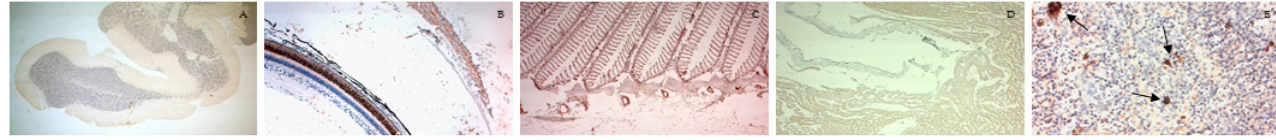
C: 1%; D: 2%; E: 3% w / w F1-BEO), highlighting significant differences in all organs (Figure